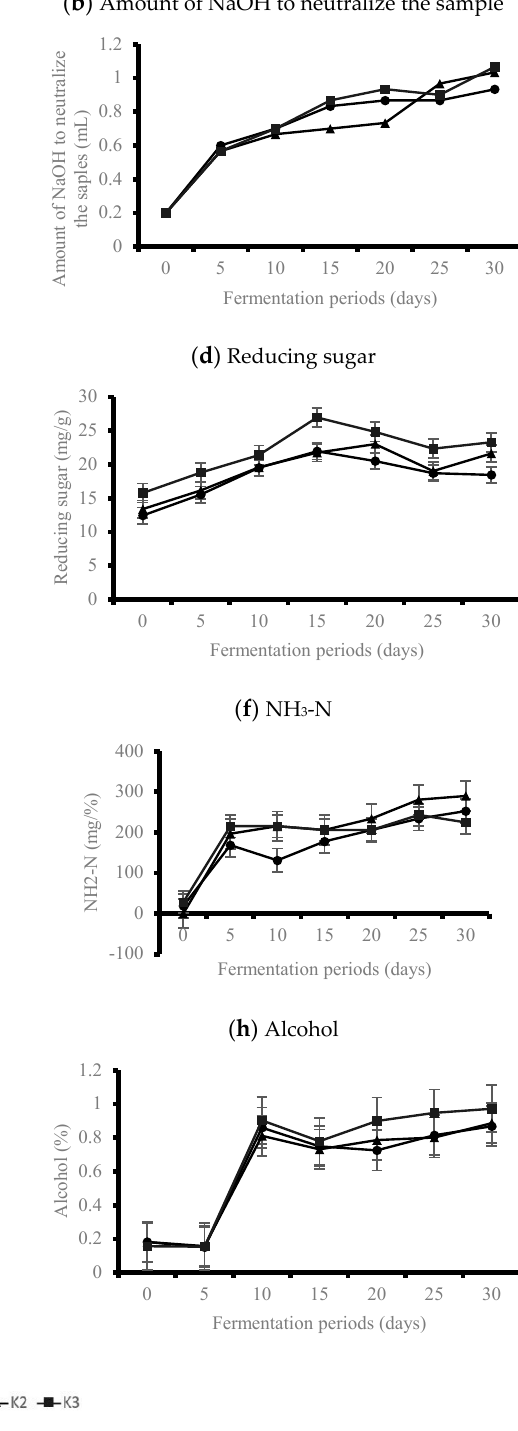
Figure 2. Changes of physiochemical characteristics of doenjang during 30 days of fermentation period. ( a ) pH, ( b ) amount of NaOH to neutralize the sample, ( c ) Acid value, ( d ) Reducing sugar, ( e ) Total sugar, ( f ) NH 3 -N ( g ) Moisture, ( h ) Alcohol. The amount of NaOH to neutralize the sample of the doenjang samples increased as the fermentation progressed in all the samples (Figure 2b). The amount of NaOH to neu- tralize the sample increased from 0.20 mL to 0.93 mL in K1 from 0.20 mL to 1.03 mL in K2,